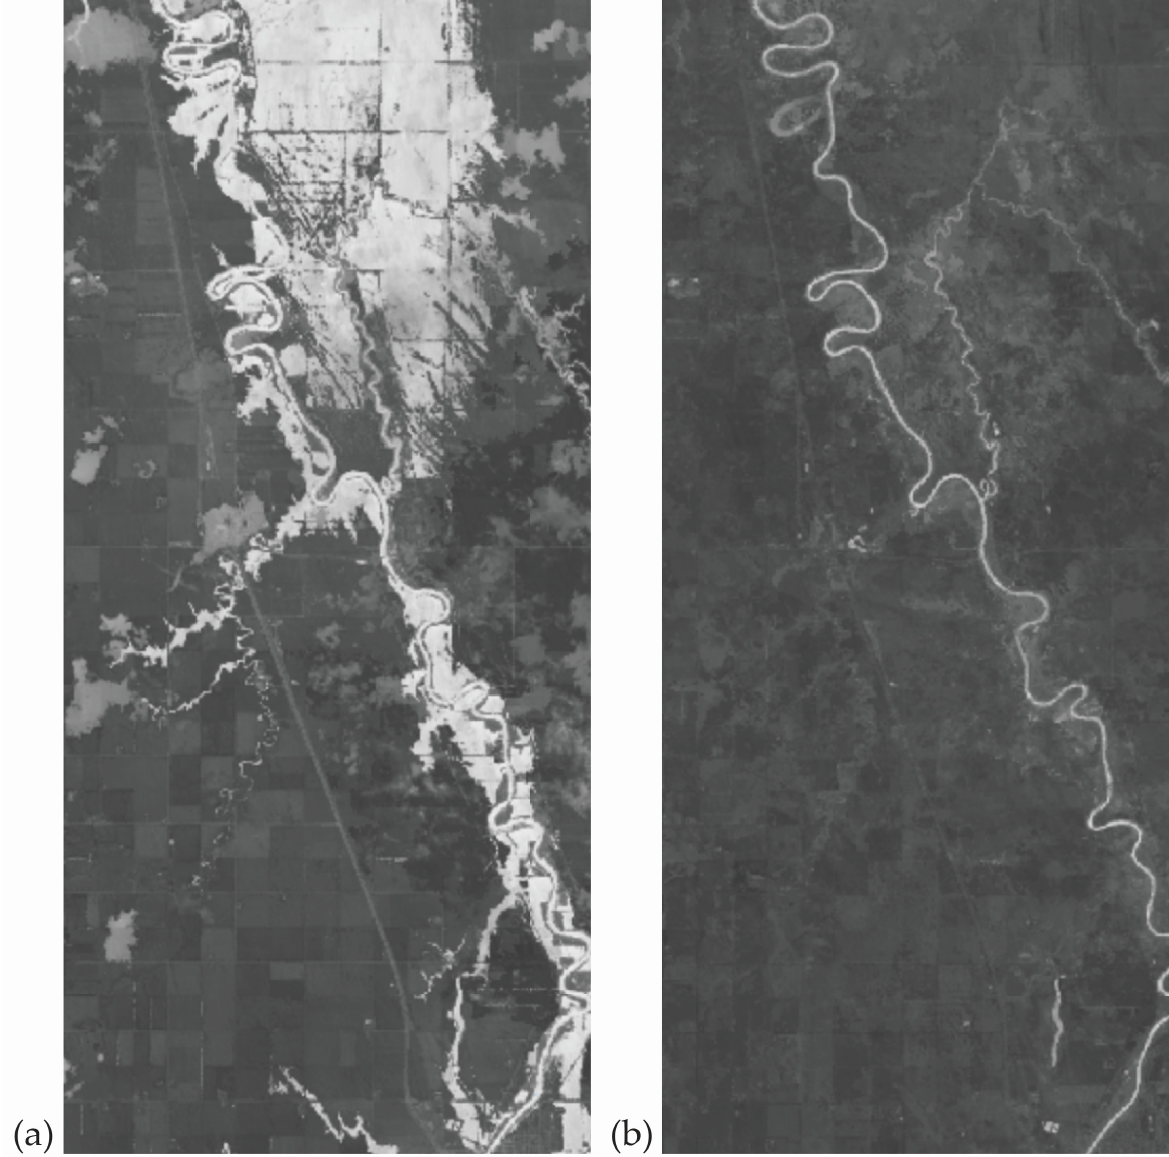
Figure 4. MNDWI for ( a ) 10 percentile (temporary water); ( b ) 40 percentile images (permanent